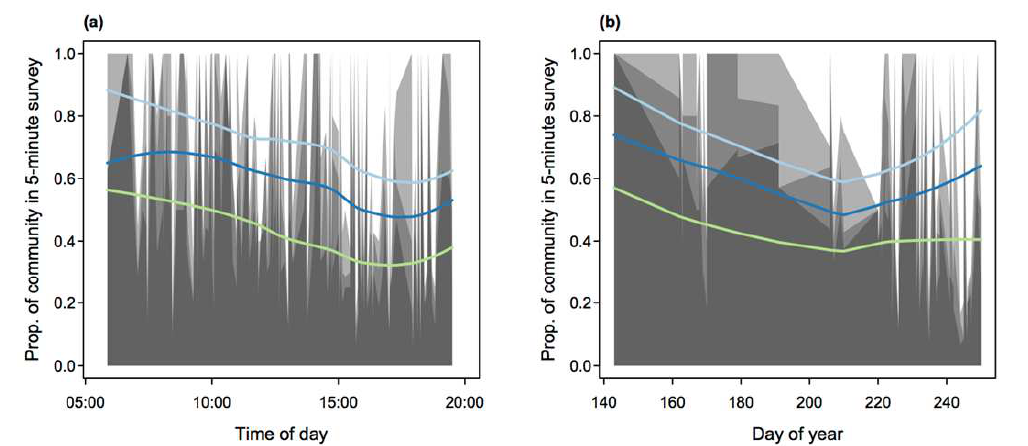
Figure A2. The proportion of bird species richness detected during 5-minute survey, in relation to the time-of-day (a) and the day of year (b). Proportions are relative to 30-minute (light gray), 60-minute (medium gray), and 120-minute (dark gray) bird surveys at 150 sites. Loess curves for 30- (light blue), 60- (dark blue), and 120-minute (light green) surveys show trends in proportions in relation to time-of-day and day of